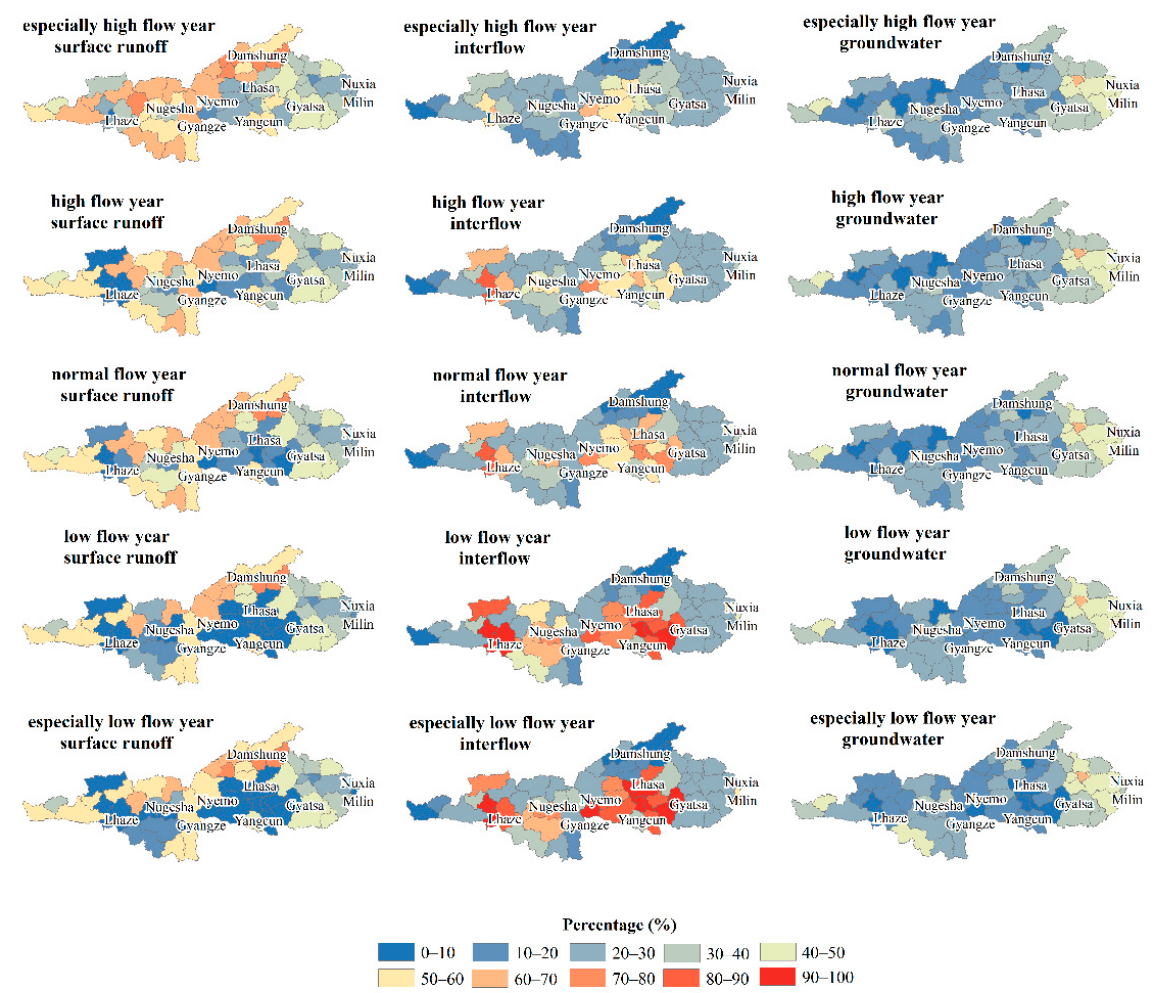
Figure 7. Spatial distribution of different runoff components in the subbasins.